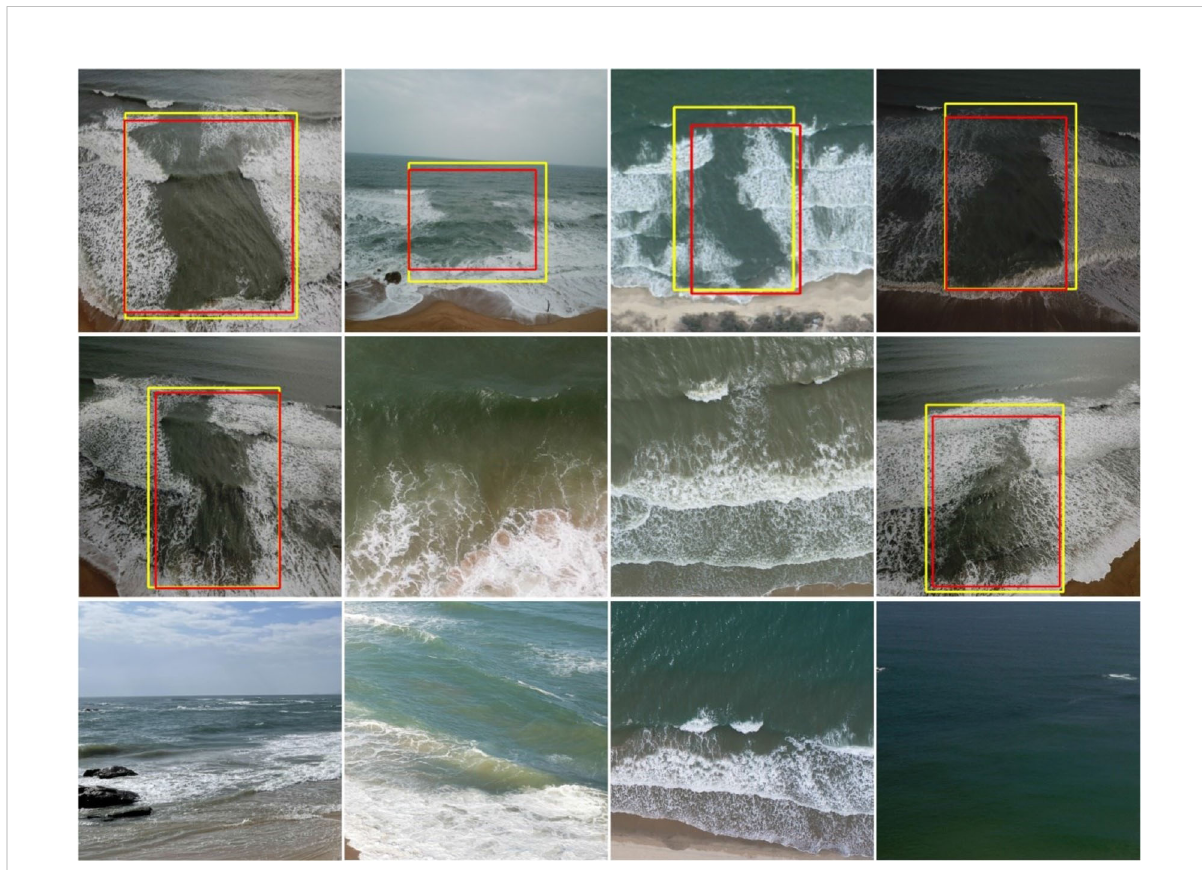
FIGURE 8 Detection performance of YOLO-Rip. The red bounding boxes represent manually de fi ned rips, and the yellow bounding boxes depict rips detected by the model. The absence of bounding boxes in the image indicates the absence of rip